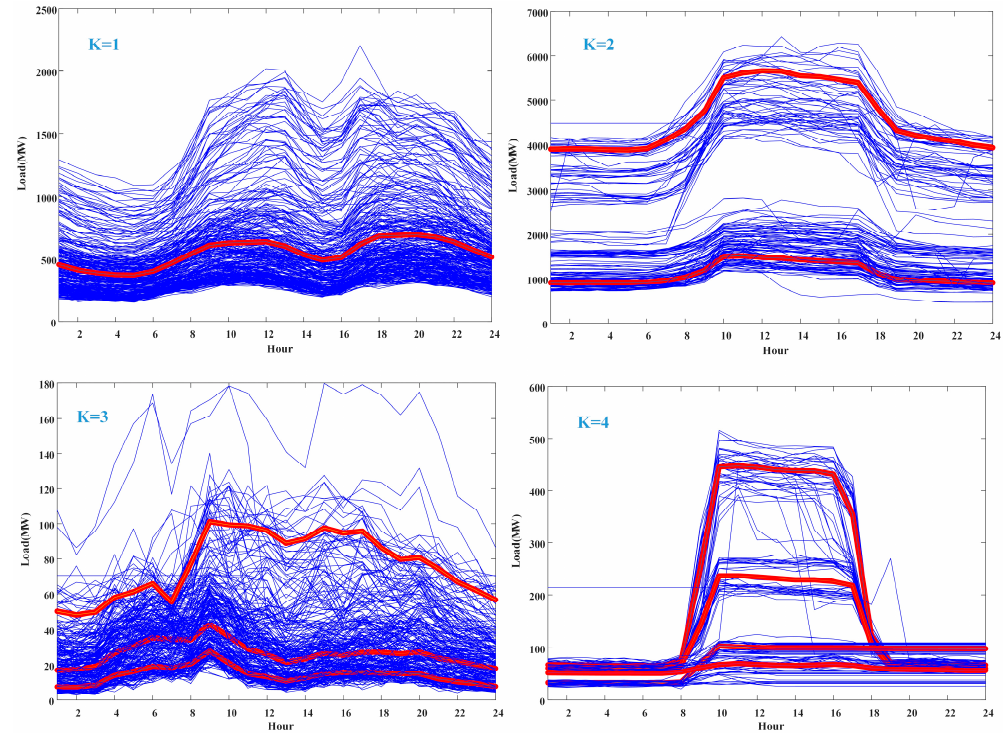
Figure 4. Numbers of clusters of each customer.